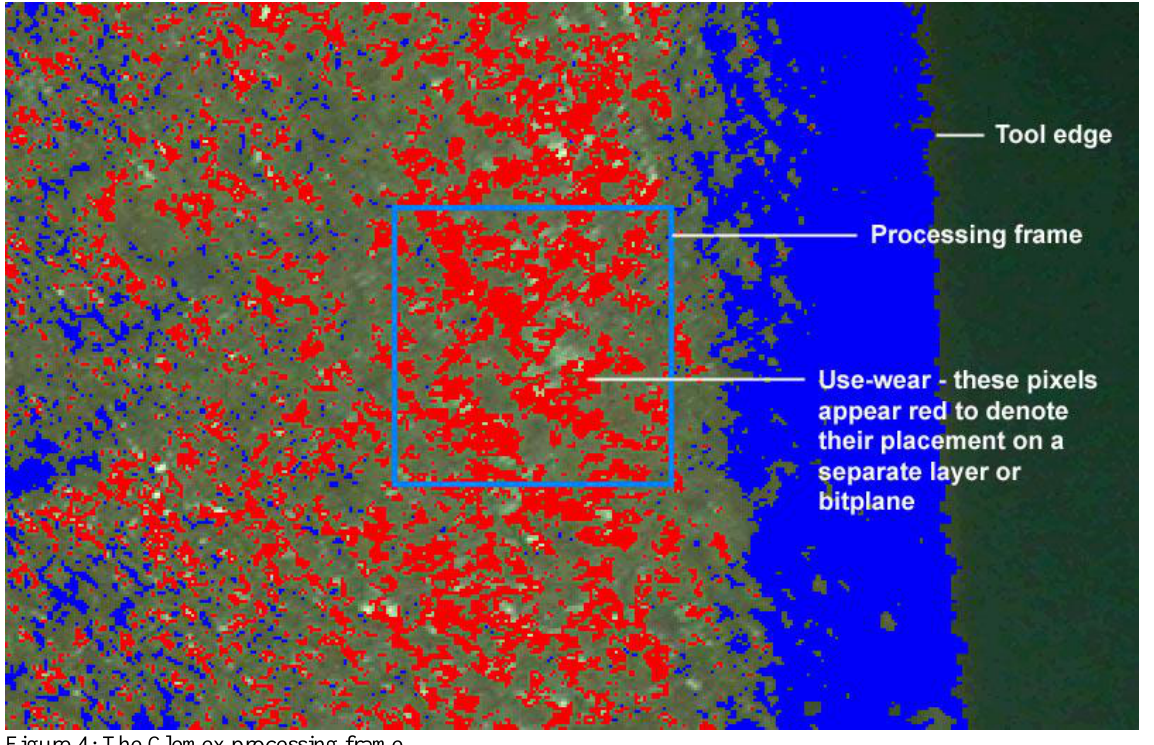
Figure 4: The Clemex processing